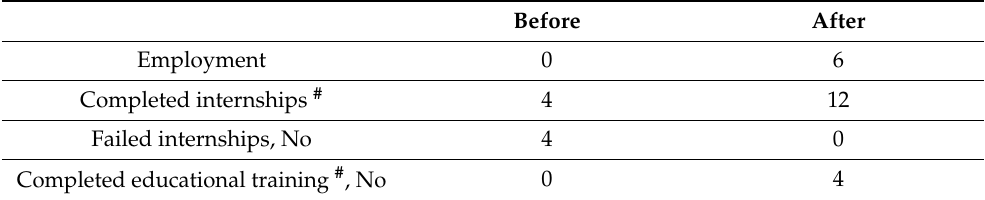
Table 3. One-year incidence of labor market before and after intervention (n = 28)